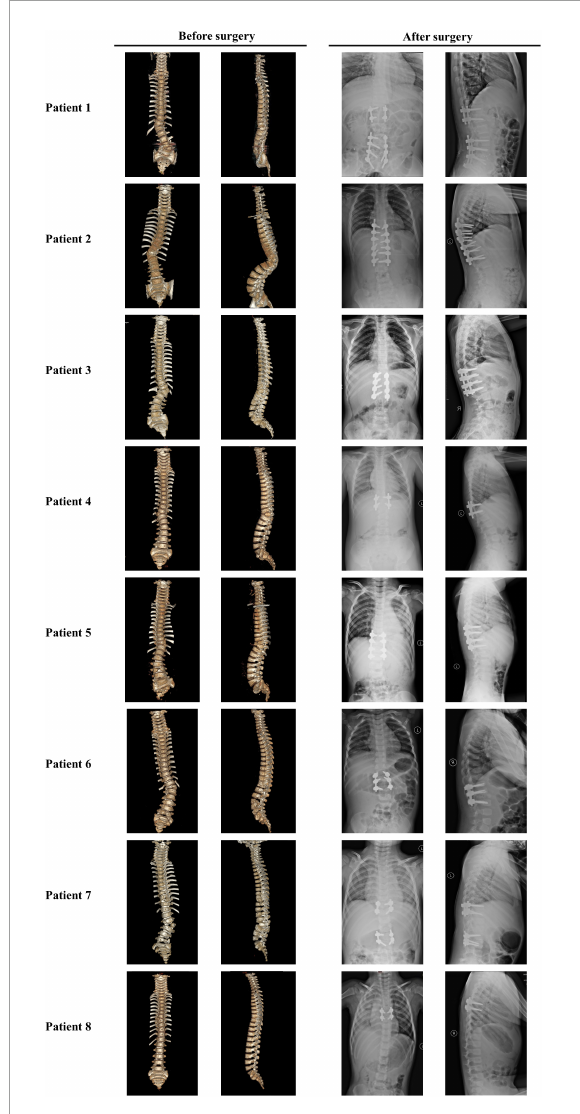
FIGURE4 Images of patients with TACS before and after surgeries suggested well outcomes. Patient 1 had hemivertebrae at T12 and L5 with the Cobb angle of 26 ◦ ; after surgery, the Cobb angle was reduced to 2 ◦ . Patient 2 had hemivertebrae at T11 with the Cobb angle of 53 ◦ ; after surgery, the Cobb angle was reduced to 87 ◦ . Patient 3 had hemivertebrae at T12 and butterfly vertebrae at T11 with the Cobb angle of 50 ◦ ; after surgery, the Cobb angle was reduced to 5 ◦ . Patient 4 had hemivertebrae at T11 with the Cobb angle of 41 ◦ ; after surgery, the Cobb angle was reduced to 0 ◦ . Patient 5 had hemivertebrae at T11 and butterfly vertebrae at L4 and S3 with the Cobb angle of 30 ◦ ; after surgery, the Cobb angle was reduced to 3 ◦ . Patient 6 had hemivertebrae at T12 and butterfly vertebrae at L5 with the Cobb angle of 46 ◦ ; after surgery, the Cobb angle was reduced to 6 ◦ . Patient 7 had unsegmented hemivertebrae at T10 and L3 and butterfly vertebrae at C7 and T9 with the Cobb angle of 22 ◦ ; after surgery, the Cobb angle was reduced to 3 ◦ . Patient 8 had hemivertebrae at T8 with the Cobb angle of 26 ◦ ; after surgery, the Cobb angle was reduced to 4 ◦ . Images before and after surgeries were obtained by CT and X-ray, respectively. TACS, TBX6 -associated congenital